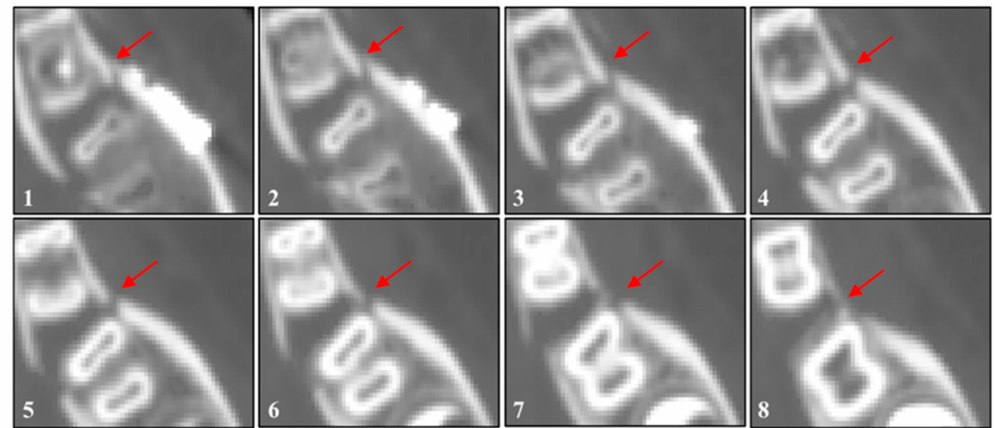
Figure 6. Region of interest at the CT scans—axial view of the left side of the mandible. The callus area for the density measurements marked as a region between bone parts (red arrows) and shown as eight planes perpendicular to the fracture line from the molar area (1) to the area beside the fixing plate (8).